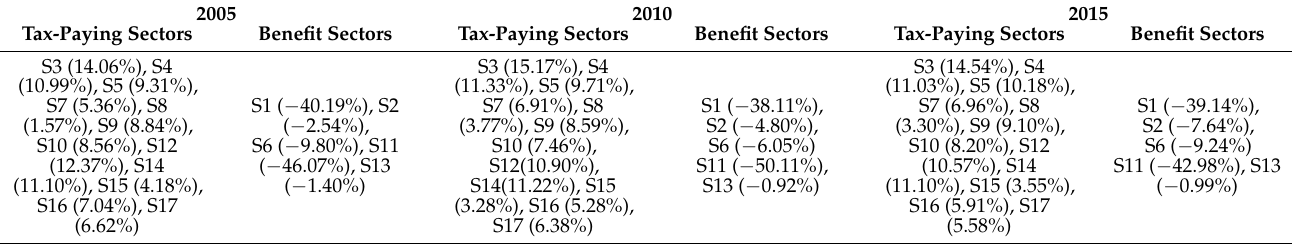
Table A3. List of related sectors on ecological consumption tax in 2005, 2010, and